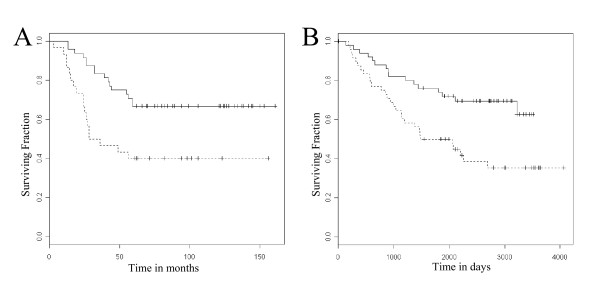
Kaplan-Meier survival curves based on the 21 gene set in independent data sets. A) van't Veer et al. data set; B) Sotiriou et al. data set. Surviving fraction for predicted good (solid lines) and poor (dashed lines) groups in the validation tumor sets are shown (P < 0.0005).